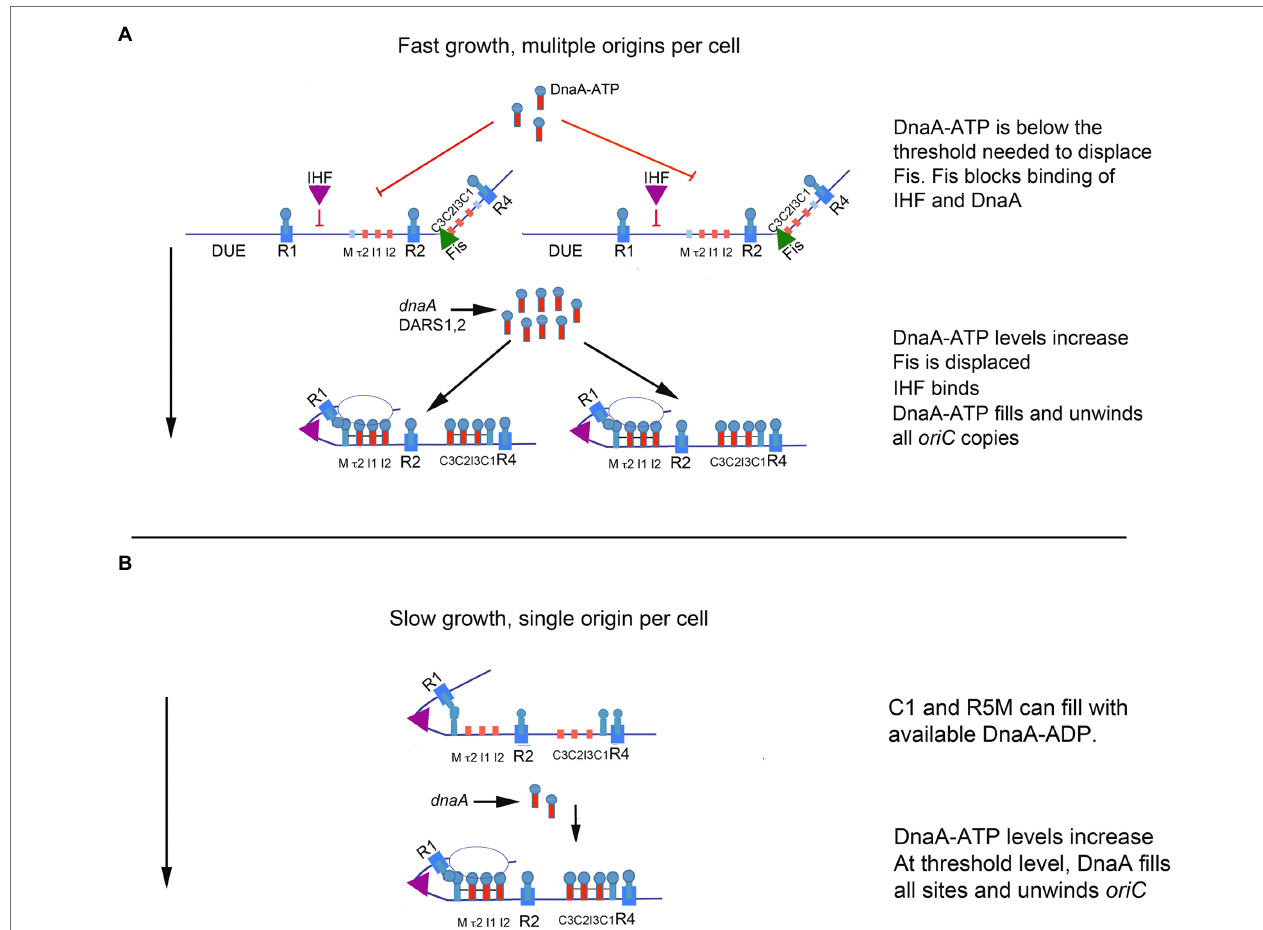
FIGURE 3 | Model of orisome assembly in fast and slow growing cells. (A) In rapidly growing cells, DnaA-ATP site occupation is regulated by Fis. Bound Fis prevents free DnaA-ATP from occupying oriC and excess DnaA-ATP (provided by new synthesis and DARS2) accumulates. When sufficient DnaA-ATP becomes available, Fis is displaced. Loss of Fis allows IHF to bind to oriC , and available DnaA-ATP binds to low affinity sites on all oriC copies in the cell. Orisome assembly may be completed by an initiation cascade (see text for details). (B) In slowly growing cells, cells contain a single copy of oriC , bound to IHF throughout the cell cycle. All low affinity DnaA-ATP sites become occupied as DnaA-ATP becomes available (see text for details). When enough DnaA-ATP has accumulated to fill all sites in the left region of oriC , the origin is unwound. The figure is adapted from Rao et al.